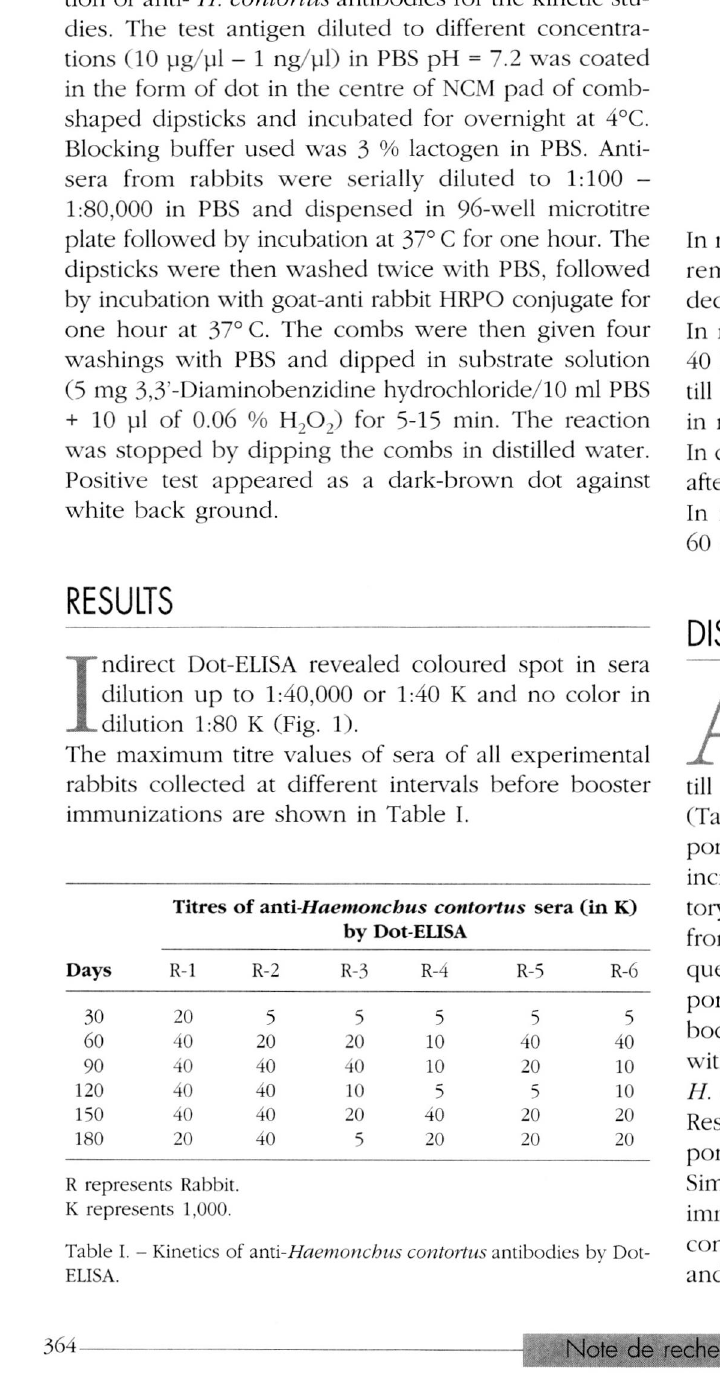
Fig. 1. - Titration of ;\n\\-Haemonchus contortus antibodies by Dot- ELISA. Spot 1. No antigen, no antibody 2. No antigen, immune rabbit serum (1:100) 3. No antibody 4. Pre immune serum - 1:100 5. Immune rabbit serum - 1:500 6. Immune rabbit seaim - 1:1.000 or 1:1K antigen = 1 ug/ul 7. Immune rabbit serum -